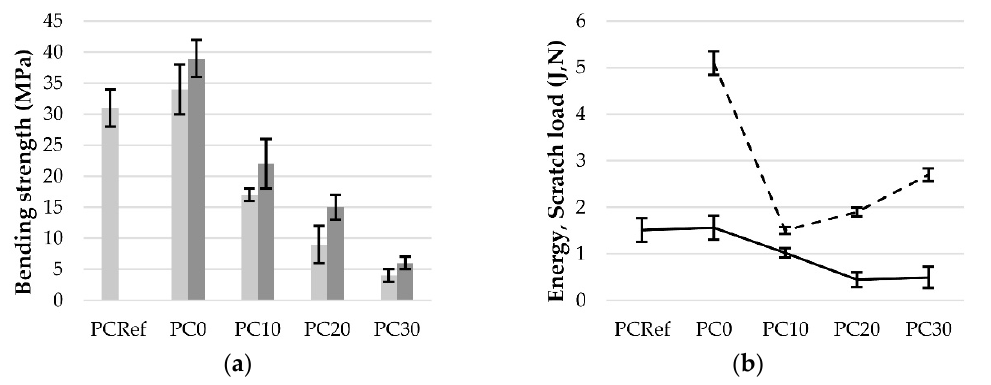
Figure 5. Mechanical characterization results for PCs: ( a ) Maximum bending stress for PCs containing 1 wt% silane coupling agents (light grey) and 4 wt% silane coupling agents (grey), ( b ) maximum impact energy (continuous line), critical scratch load (dashed line). Error bars represent standard